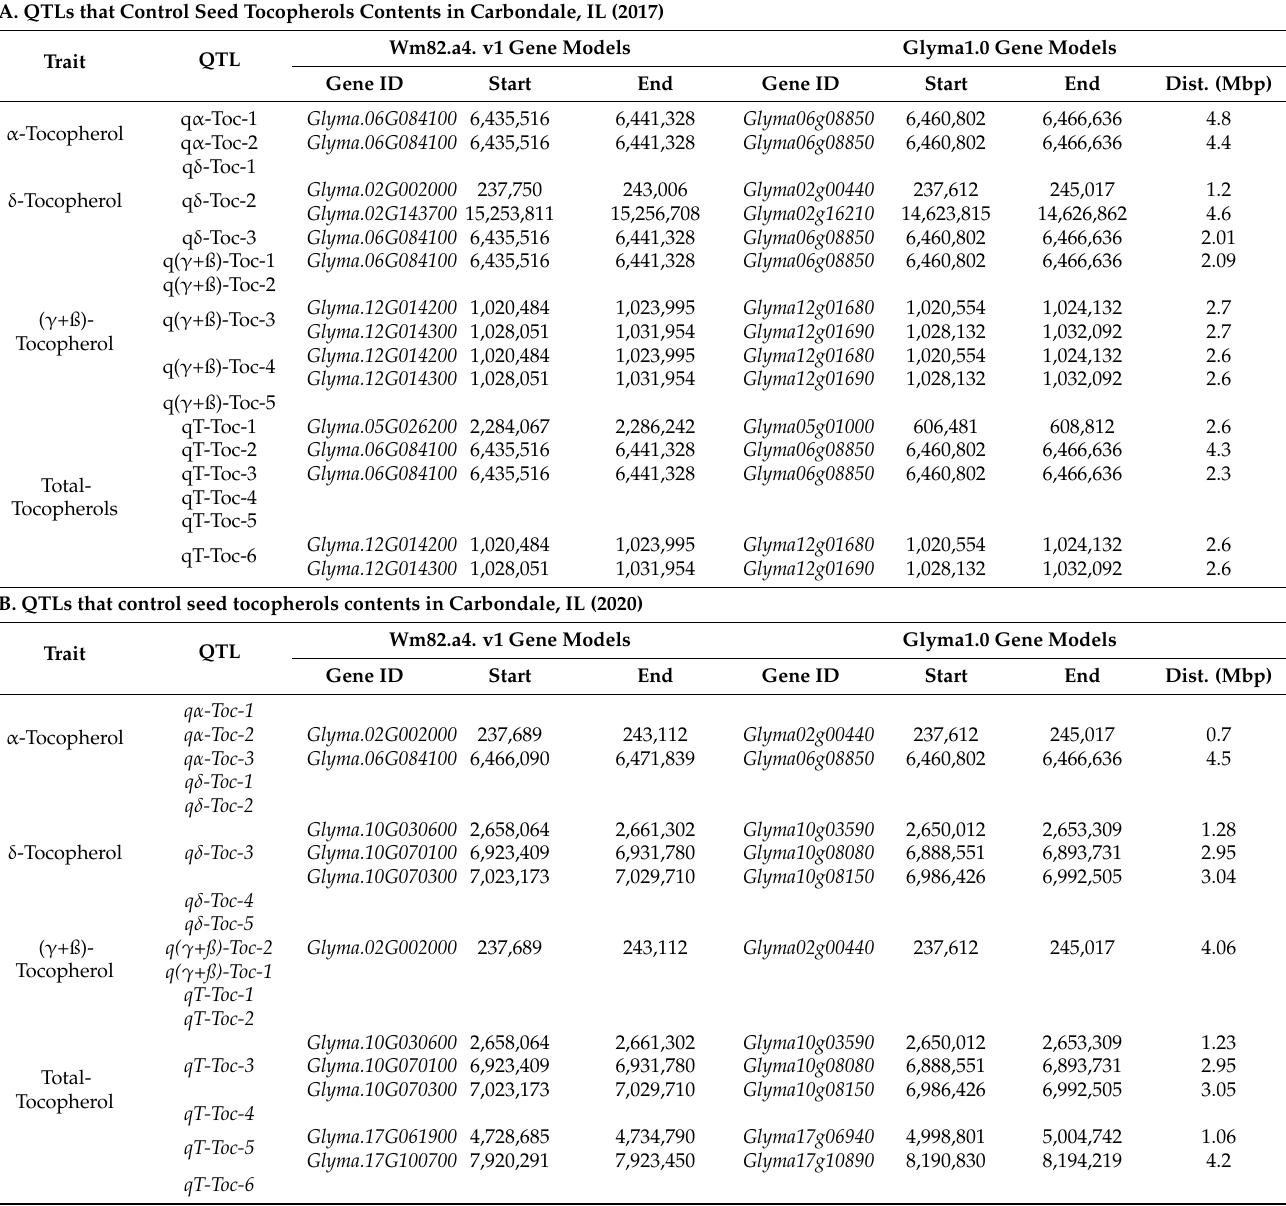
Table 4. Tocopherol candidate genes located within or close to the tocopherol QTL identified in